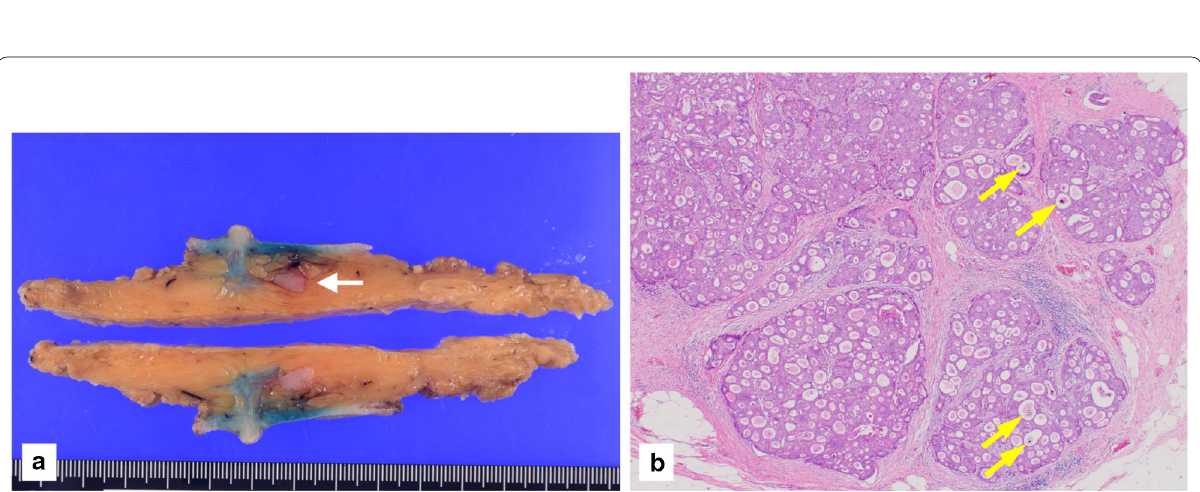
Fig. 8 Pathological findings for a resected specimen. a Macroscopically, a gray-white, well-circumscribed mass with a diameter of 1.2 observed (white arrow). b Histopathological examination revealed ICC with microcalcification (yellow arrows). Inflammatory cell infiltration was mild and focal (H&E staining, ×